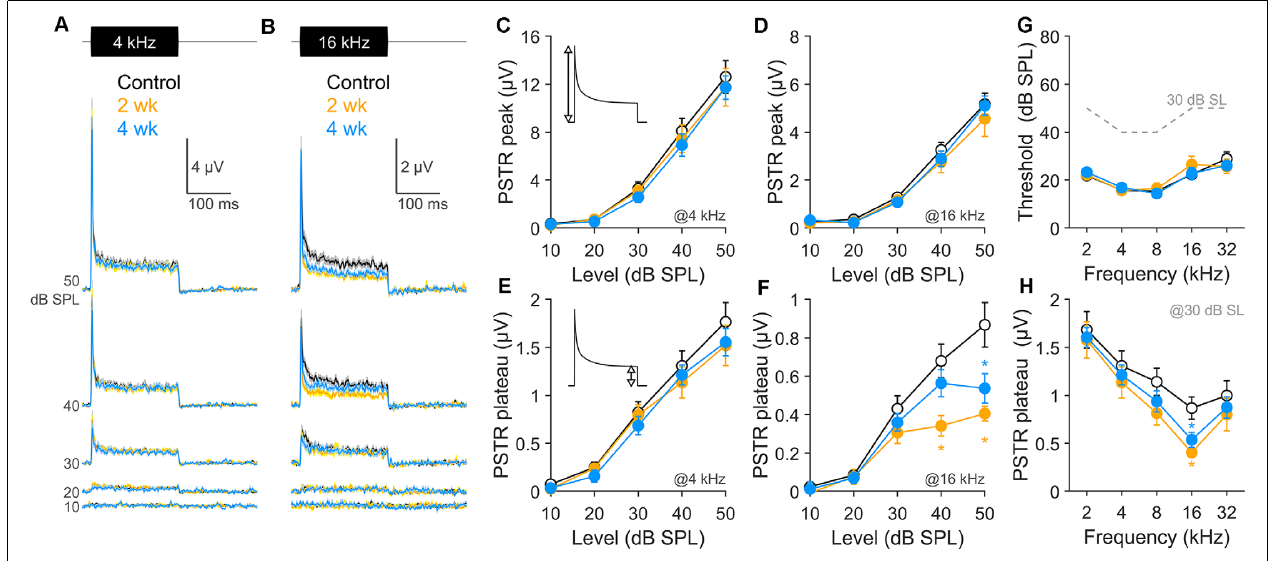
FIGURE 5 | PSTR peak and plateau after noise exposure. (A,B) Population PSTRs obtained in response to noise bursts centered at 4 kHz (A) and 16 kHz (B) , for sound levels 10–50 dB SPL, in 10 dB steps. Group sizes are as listed in the Figure 1 caption. (C–F) The amplitude of the PSTR peak at 4 kHz (C) and 16 kHz (D) and of the PSTR plateau at 4 kHz (E) and 16 kHz (F) as a function of level. Insets in (C,E) indicate the relevant measurements. (G) PSTR derived threshold. For reference, the gray dashed line indicates the sound levels at 30 dB above PSTR threshold (i.e., 30 dB SL). (H) The amplitude of the PSTR plateau at 30 dB SL as a function of the probe frequency. Data are means ± SEM; * p < 0.05, Student’s t